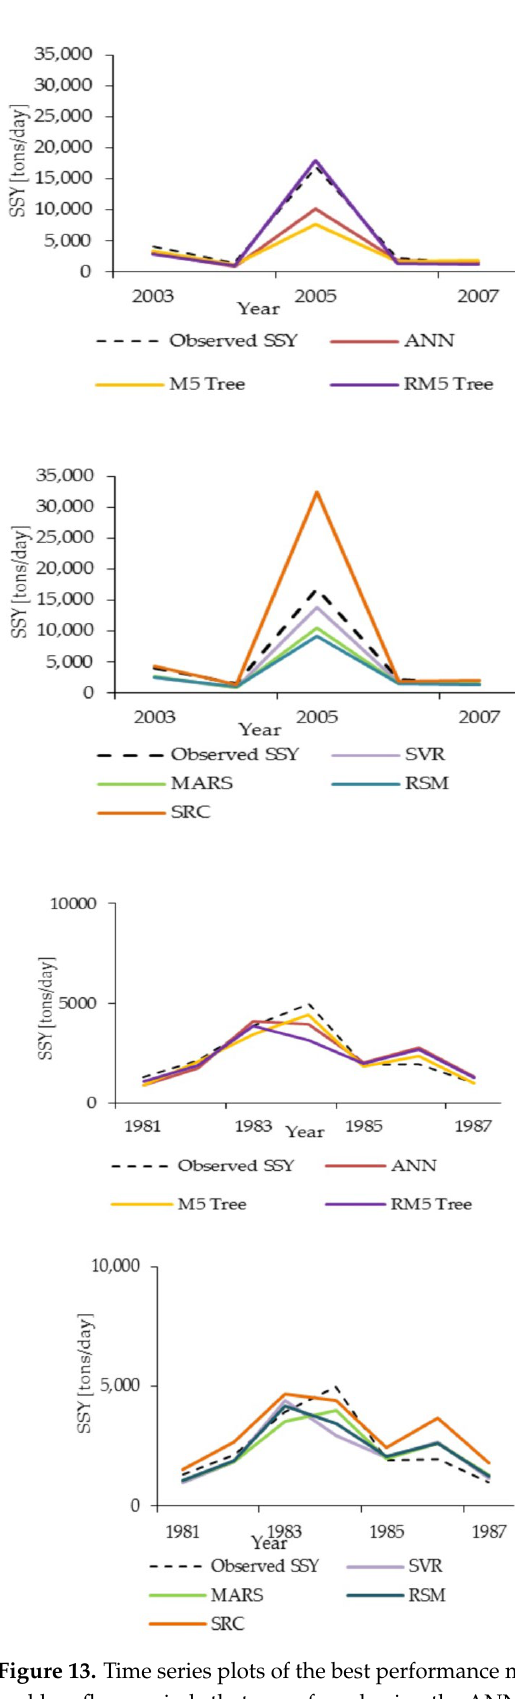
Figure 13. Time series plots of the best performance measures for the predictions of SSYs during high and low flow periods that were found using the ANN, MARS, SVR, M5Tree, RM5Tree, RSM and SRC models in predictions of sediment yields for the Gilgit Rive